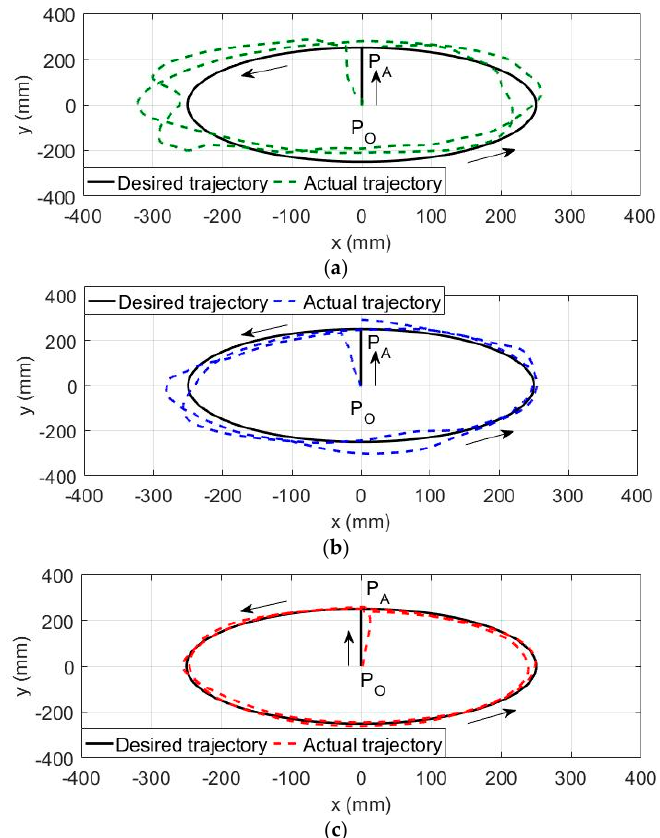
Figure 10. The results of the trajectory tracking experiments with impedance adjustment conducted by S1. ( a ) Low impedance parameters. ( b ) Medium impedance parameters. ( c ) Large impedance parameters.